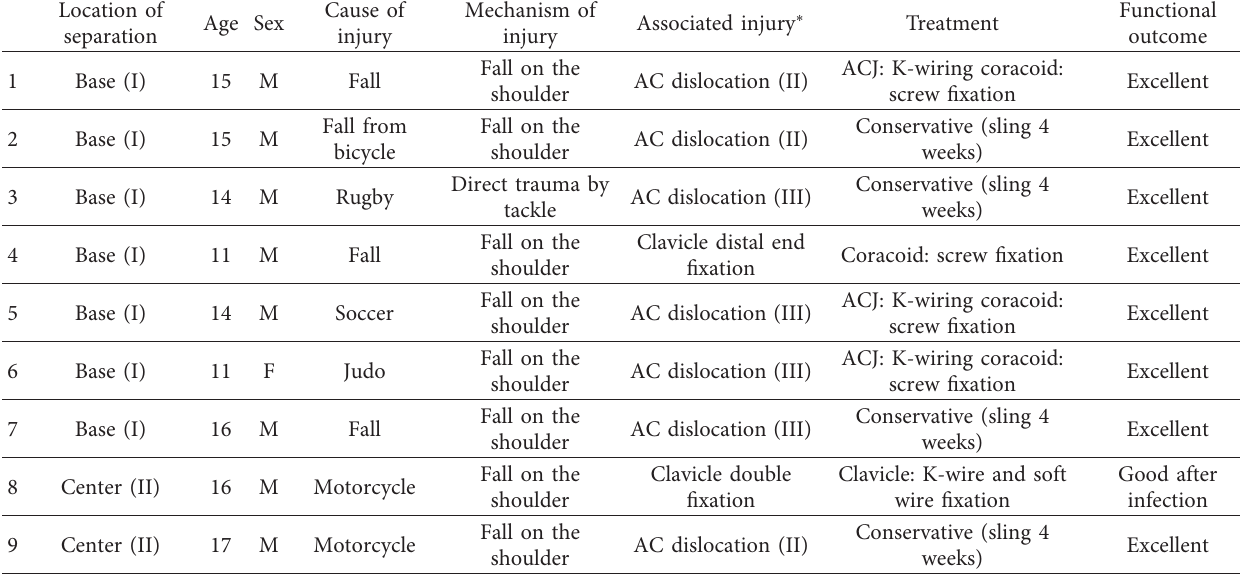
Table 1: Characteristics of patients with epiphyseal separation of the coracoid process treated in our center. Location of